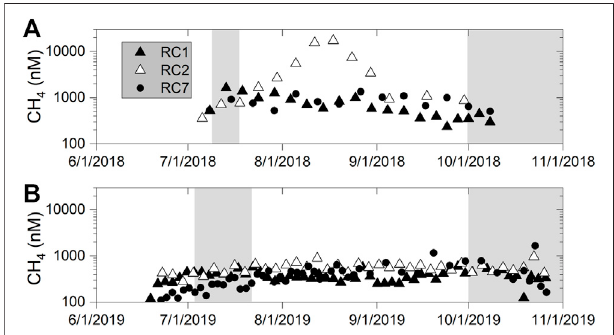
FIGURE 11 | Methane concentrations in bottom water in (A) 2018, and (B) 2019. Shaded region indicates when the aerators were turned off, otherwise, they were